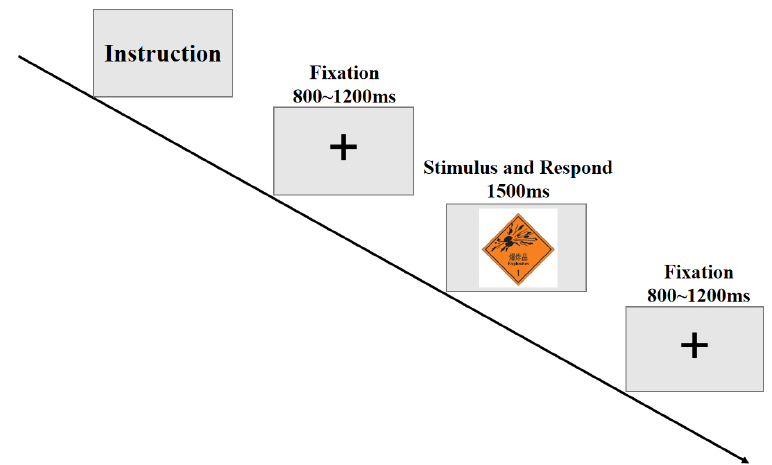
Figure 2. The behavioral experimental procedure.